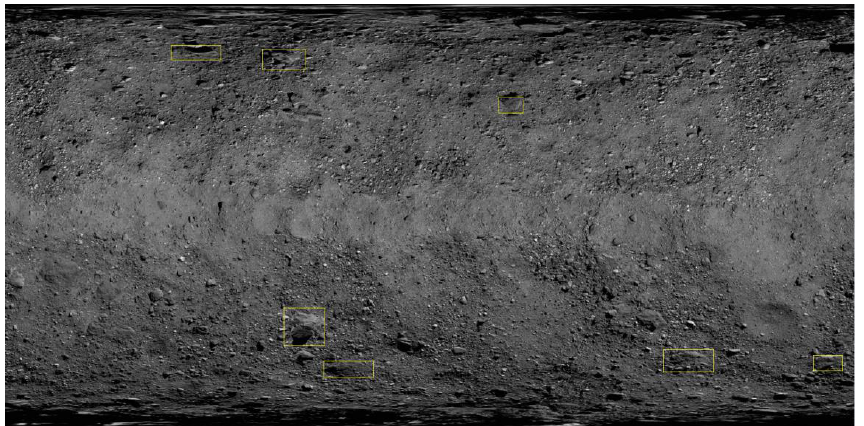
Figure 10. The distribution of the detected boulders whose diameters are more than 30 m in each